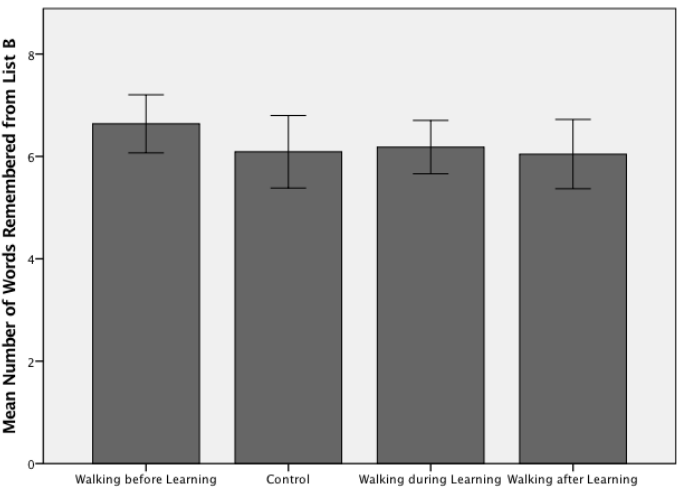
Figure 1. Free recall scores for Trial 6 (List B) across the four experimental arms for Study 1 ( n = 88; walking and learning). A one ‐ way ANOVA confirmed there were no significant group differences between the temporally varied exercised and no ‐ exercise control conditions (F(3, 84) = 0.758, p = 0.521), with an average recall score of 6.24 (SD = 1.45) words (range 3–10).